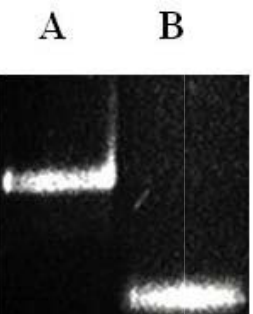
Sensors 201 Figure e 3. Gene phylog genetic vari stabiliz Polym